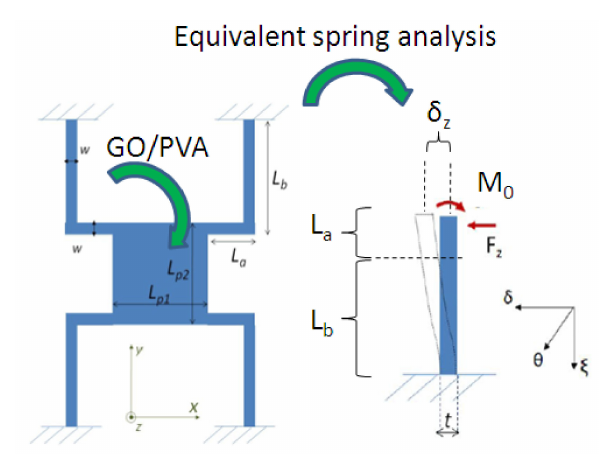
Figure 4. Schematic of the passive microresonator. The axes δ , ξ and θ have been considered to study a single spring. By using the symmetry of the structure, the response of the entire device has been modeled, with its easy axis along the z direction.